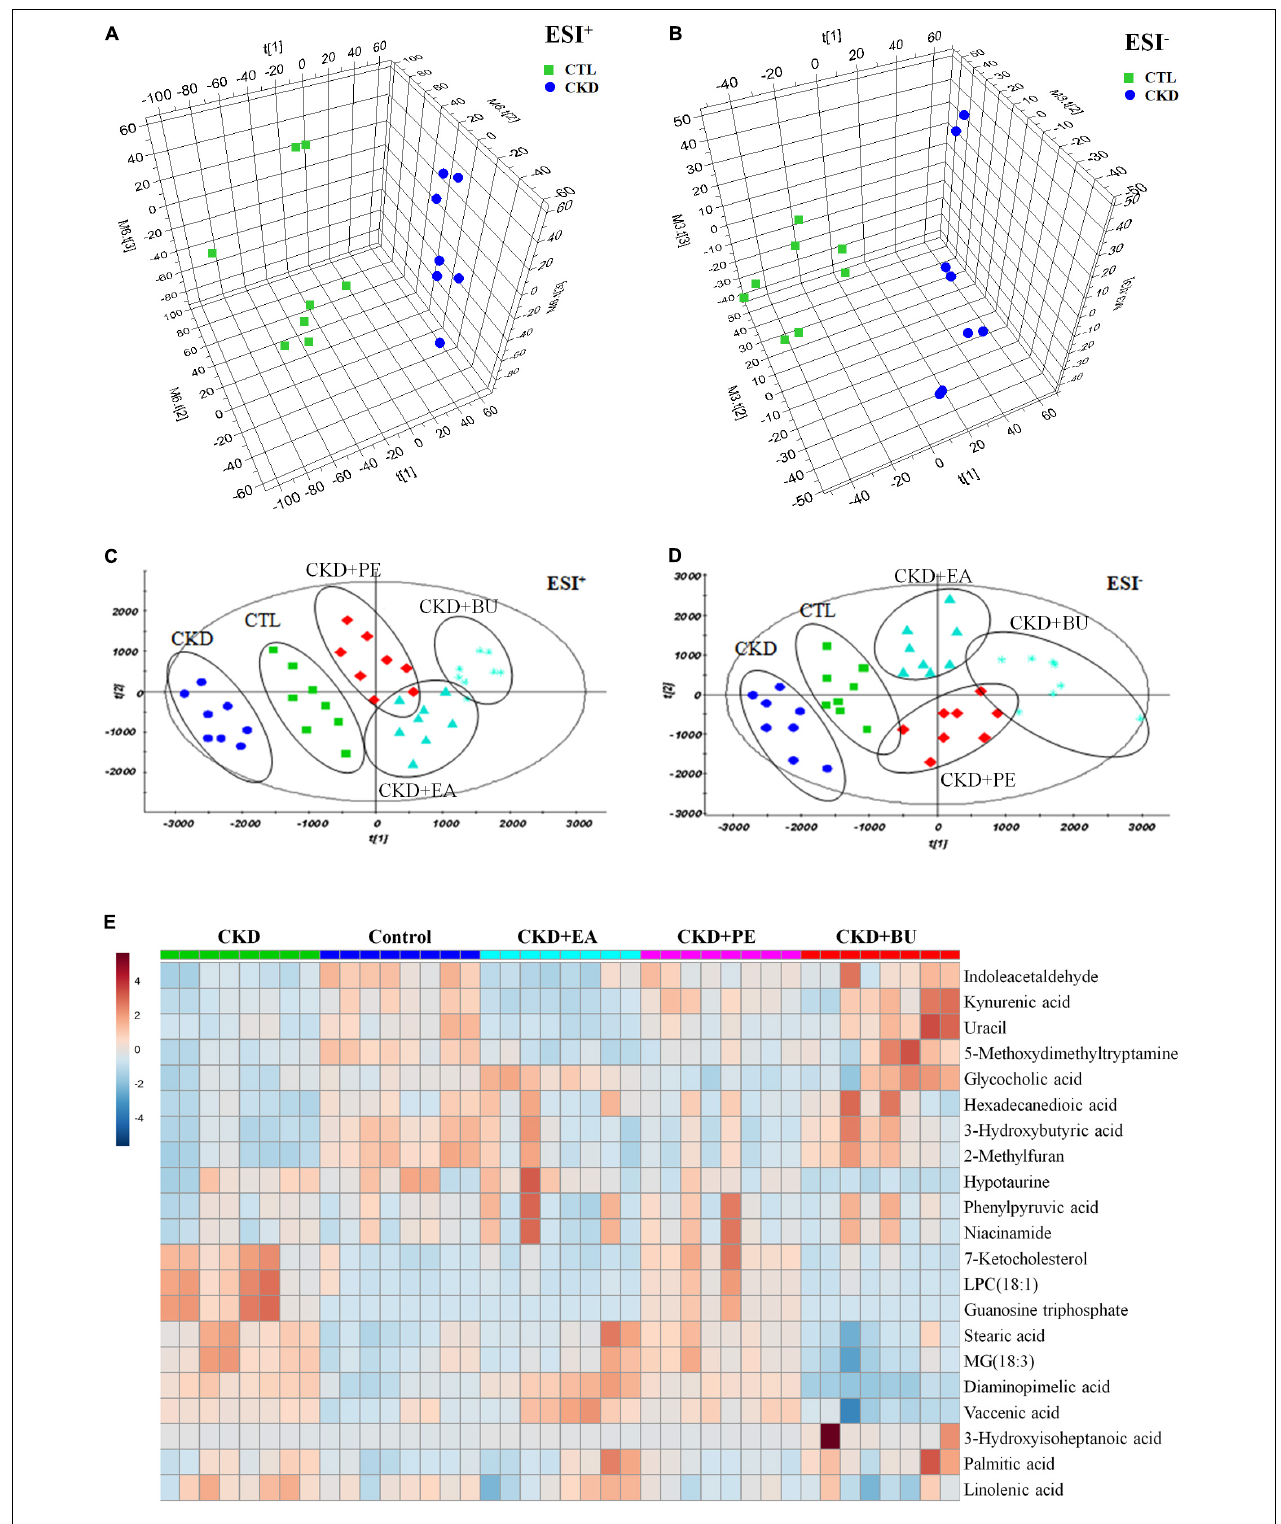
FIGURE 3 | Metabolomic profiling of tissue samples. (A) PCA scores plot from CKD samples and control samples in positive ion mode. (B) PCA scores plot from CKD samples and control samples in negative ion mode. (C) PCA scores plot of comparing control, CKD, CKD+PE, CKD+EA, and CKD+BU groups in positive ion mode. (D) PCA scores plot of comparing control, CKD, CKD+PE, CKD+EA, and CKD+BU groups in positive ion mode. (E) Heat maps for 21 altered metabolites. Red and blue indicate increased and decreased levels, respectively. Rows, metabolites; columns, tissue samples.